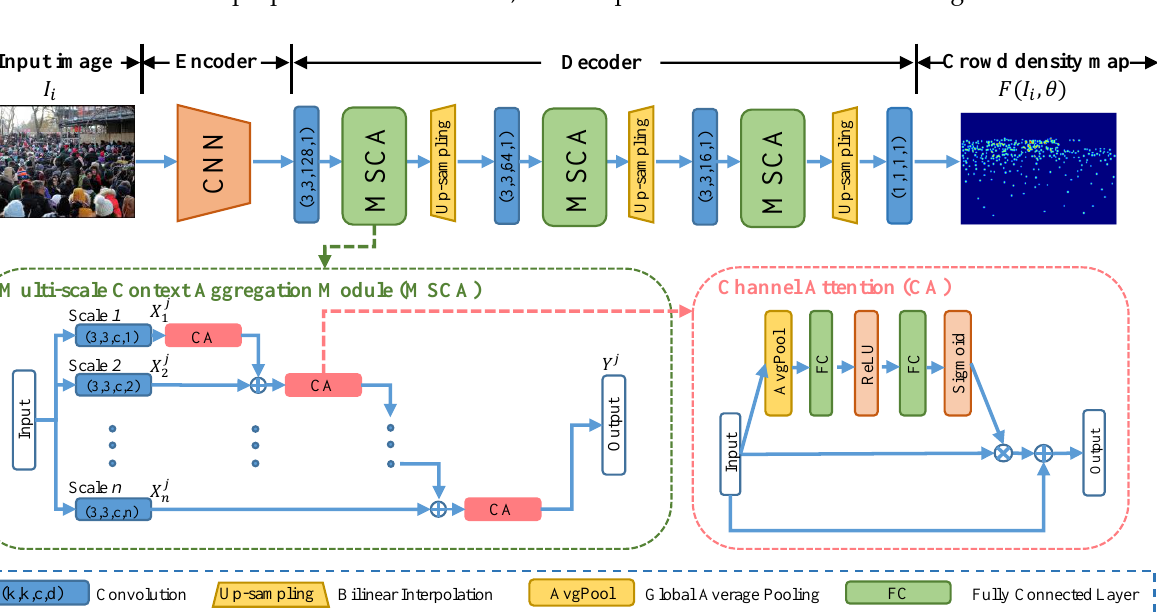
· · · 1 j ∈ { 1 , 1 , 1 } as the dilated rate, reduction ratio, and resolution of the feature map, 4 2 2 r − 1 respectively. The context feature is represented by X j